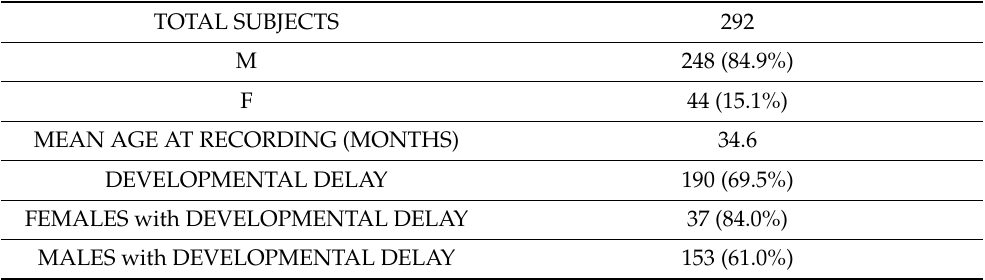
Table 1. Cohort data and results.